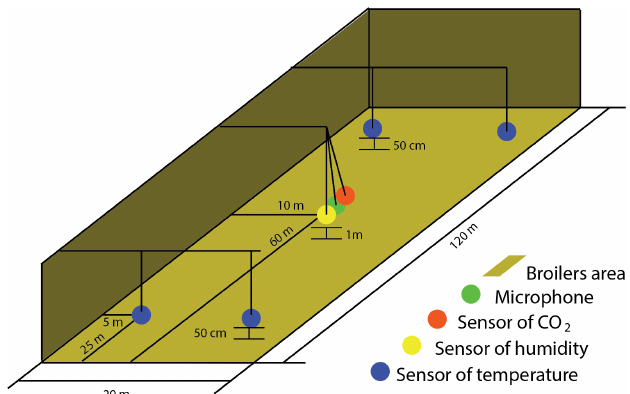
Figure 3. Diagram of the sensors location in the H1 farm, microphone, CO 2 sensor, humidity, and temperature